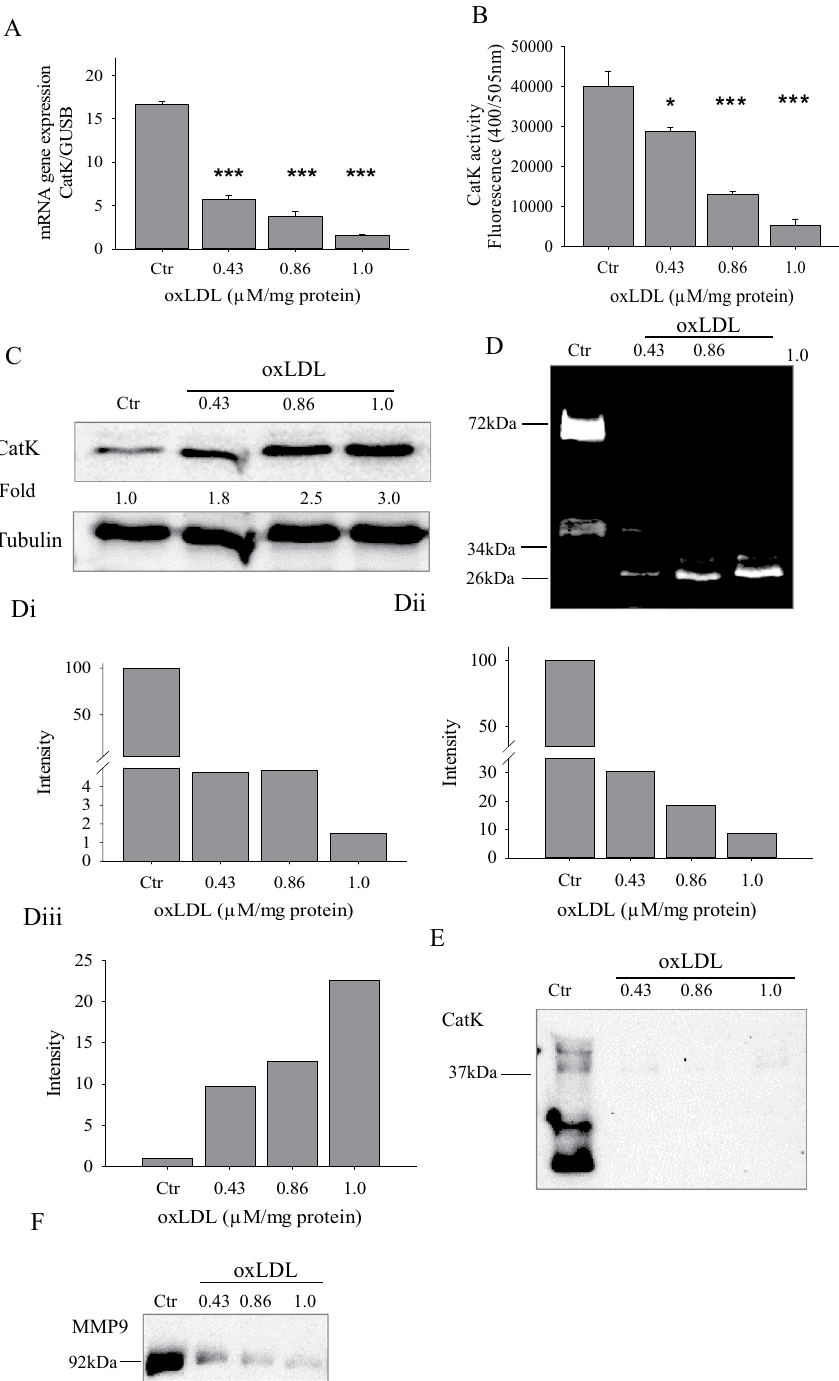
Figure 4. oxLDL regulates the gene expression and secretion of CatK. Osteoclasts were stimulated with different concentrations of oxLDL. ( A ) mRNA expression of CatK with and without oxLDL ( B ) CatK activity by fluorometric assay using synthetic substrate in control and oxLDL treated cells. ( C ) Cells treated with and without oxLDL for 3 days were lysed and equal amount of cell lysates were western blotted for CatK. ( D ) Conditioned media from control and oxLDL treated osteoclasts were subjected to gelatin zymography at day 8; intensity quantification in Di–iii. ( E ) Conditioned media were subjected to western blot analysis at day 8 and probed with the CatK antibody. ( F ) Conditioned media were subjected to western blot analysis at day 8 and probed with the MMP-9 antibody. Images from both zymography and western blot were captured using the VersaDoc‐3000 (Bio‐Rad Laboratories, Muenchen, Germany) and quantified using QuantityOne software (Bio‐ Rad Laboratories). Error bars represent standard deviation. n ≥